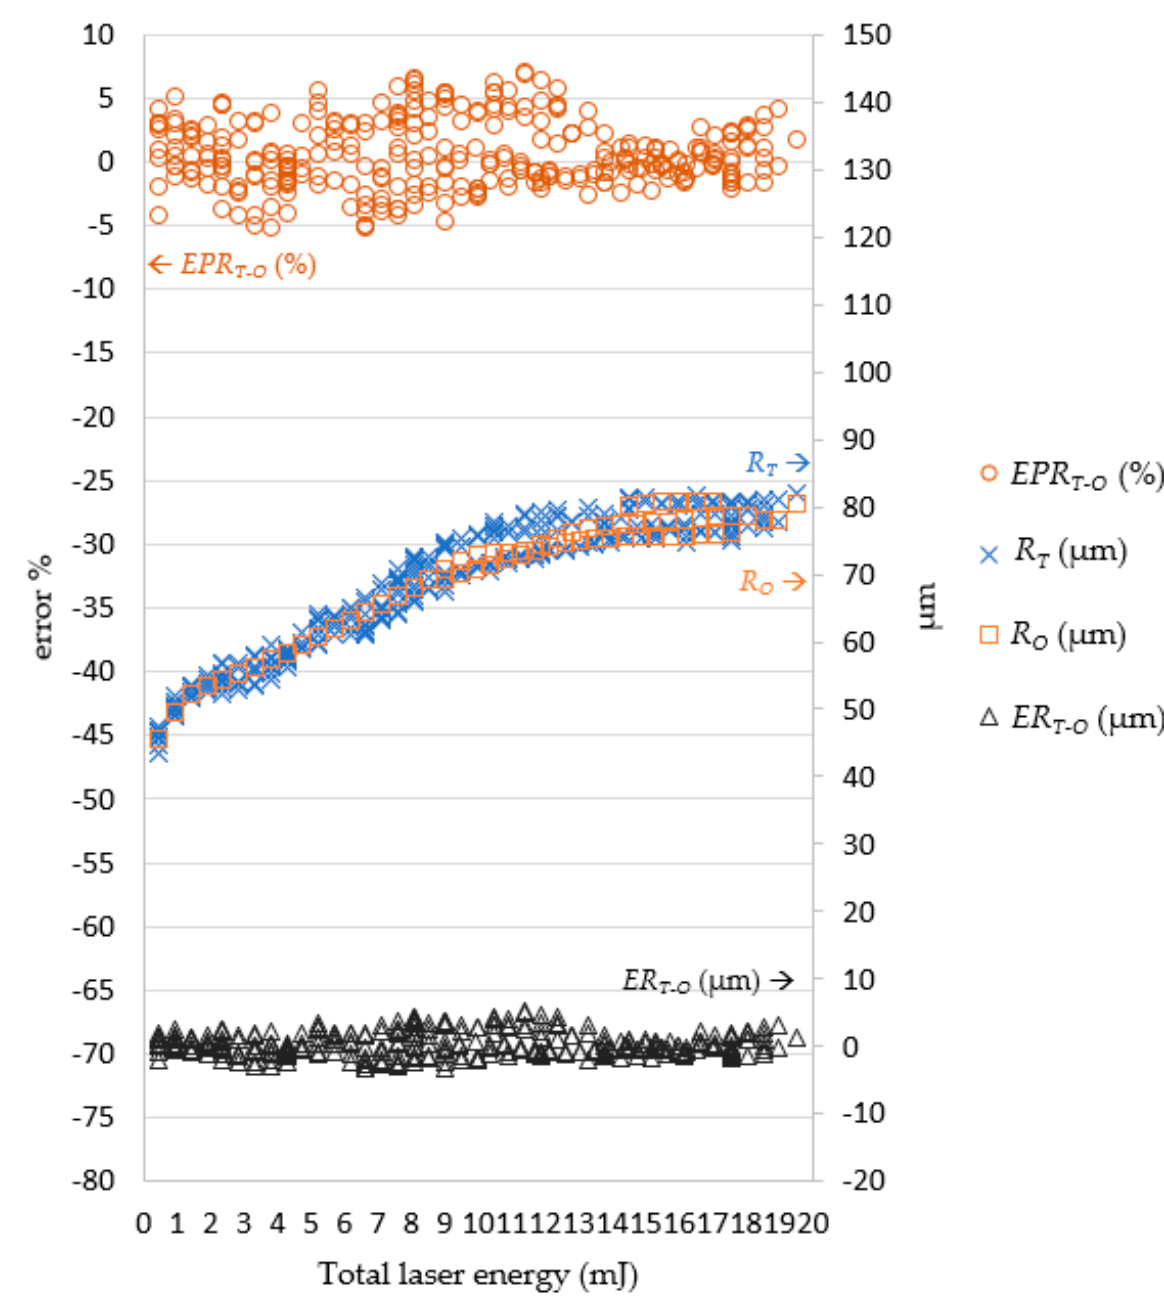
Figure 17. Comparison of R T and R O . Note: ER T-O = R T − R O ; EPR T-O = ( R T − R O )/ R O (%).